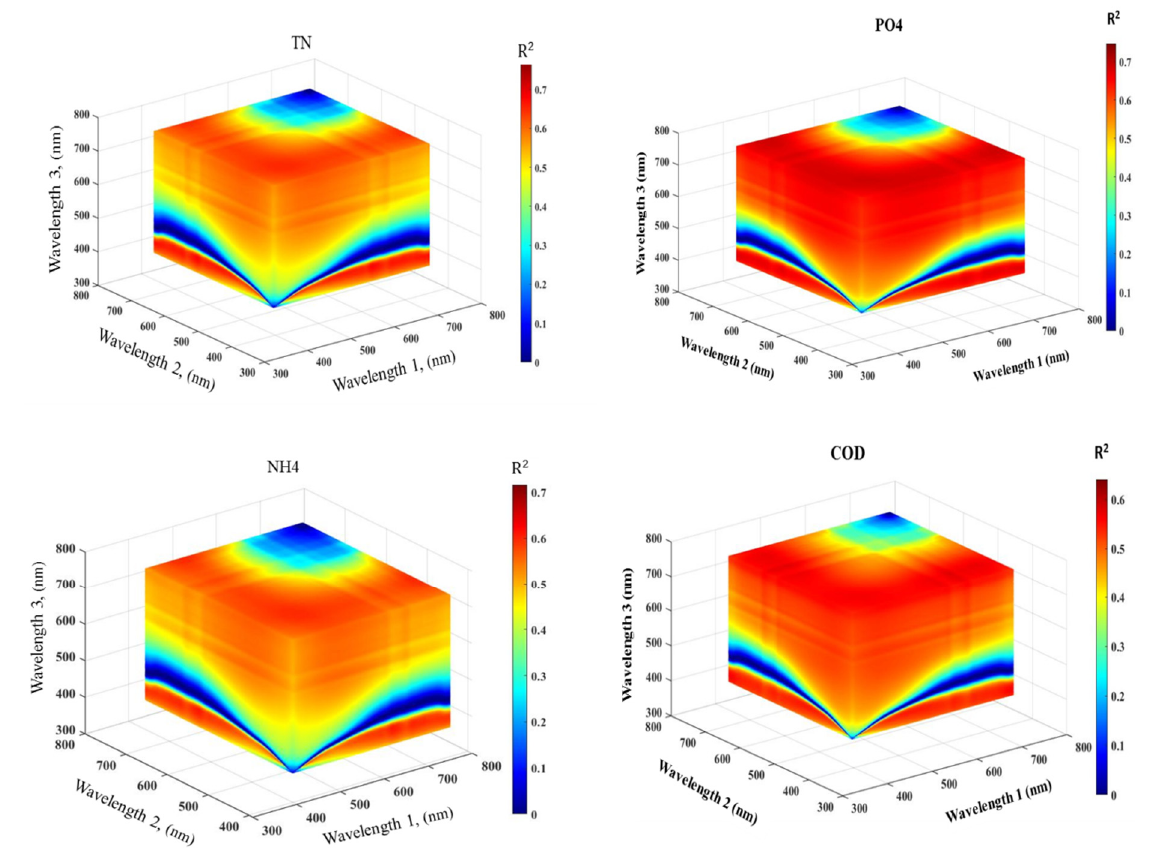
Figure 5. Three-dimensional slice map of the determination coefficients (R 2 ) values that were obtained for the relationship between total nitrogen (TN), ammonium (NH 4+ ), orthophosphate (PO 43 − ), and chemical oxygen demand (COD) over two years that was calculated for all potential combinations of each three-band from 390–750 nm. Table 6. Determination coefficients (R 2 ) values for the relationship among 18 SRIs and total nitrogen (TN), ammonium (NH 4+ ), orthophosphate (PO 43 − ), and chemical oxygen demand (COD) over two years.